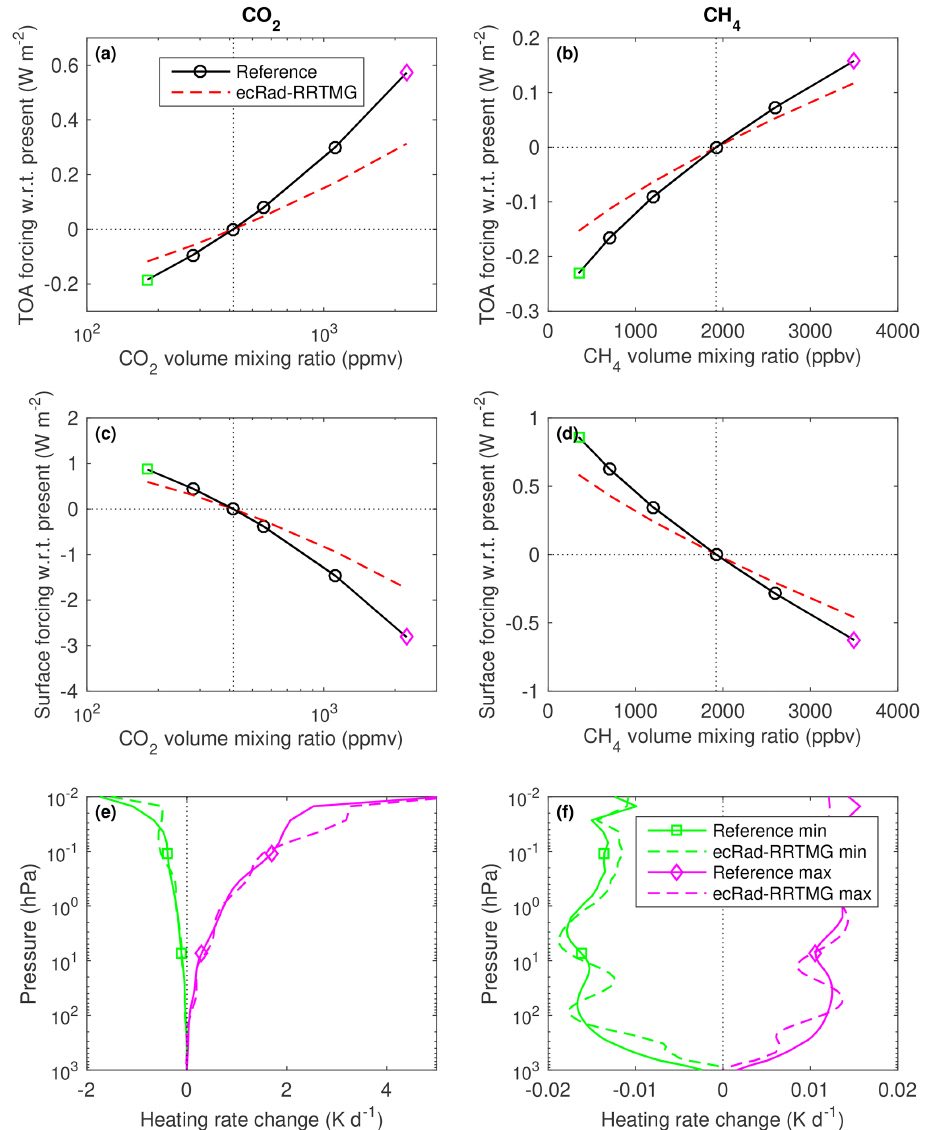
Figure 8. As Fig. 6 but for the instantaneous shortwave radiative forcing by CO 2 and CH 4 . The five solar zenith angles have been averaged, so the values shown here represent a daytime